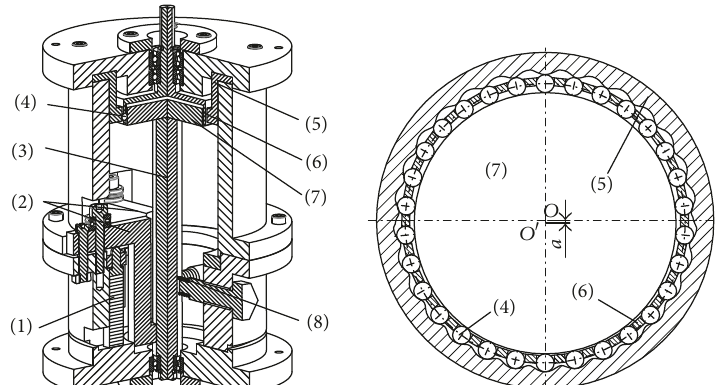
Figure 1: Movable tooth piezoelectric motor. (1) Piezoelectric actuator; (2) z-shaped rod; (3) swaying rod; (4) movable tooth; (5) rigid cog; (6) rotor; (7) wave generator; (8) spring.